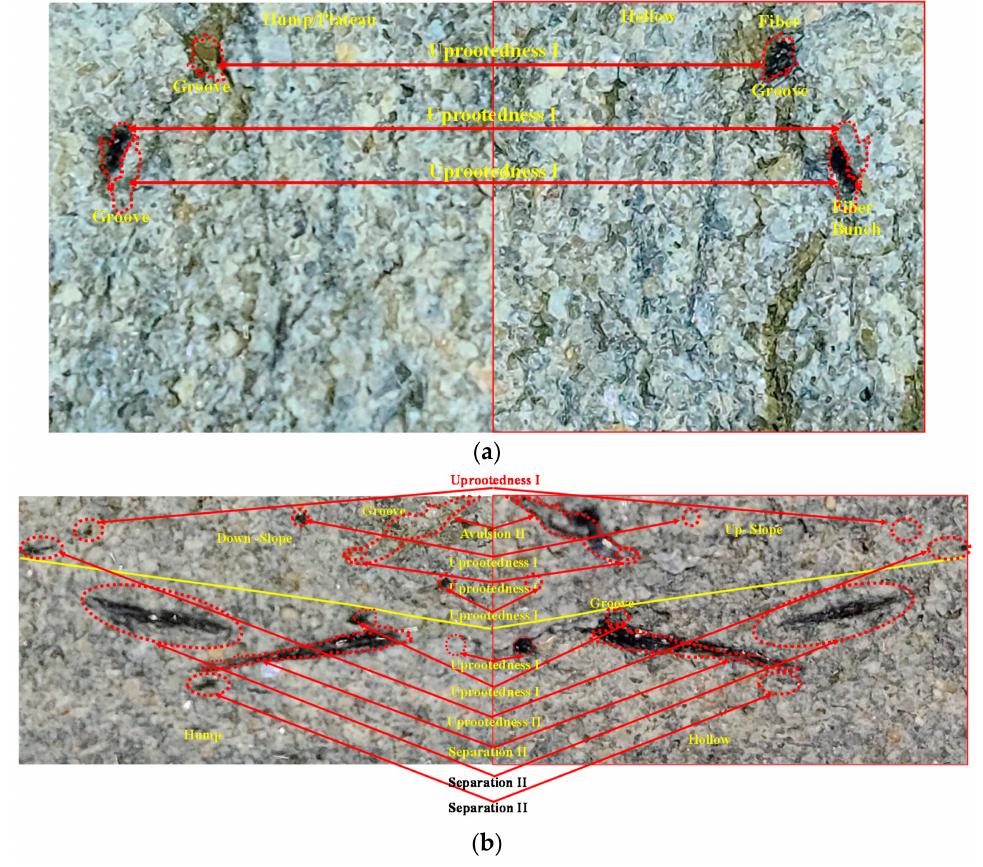
Figure 8. Fiber traces on the cracked surfaces of CF 0.5. ( a ) CF 0.5-1, ( b ) CF